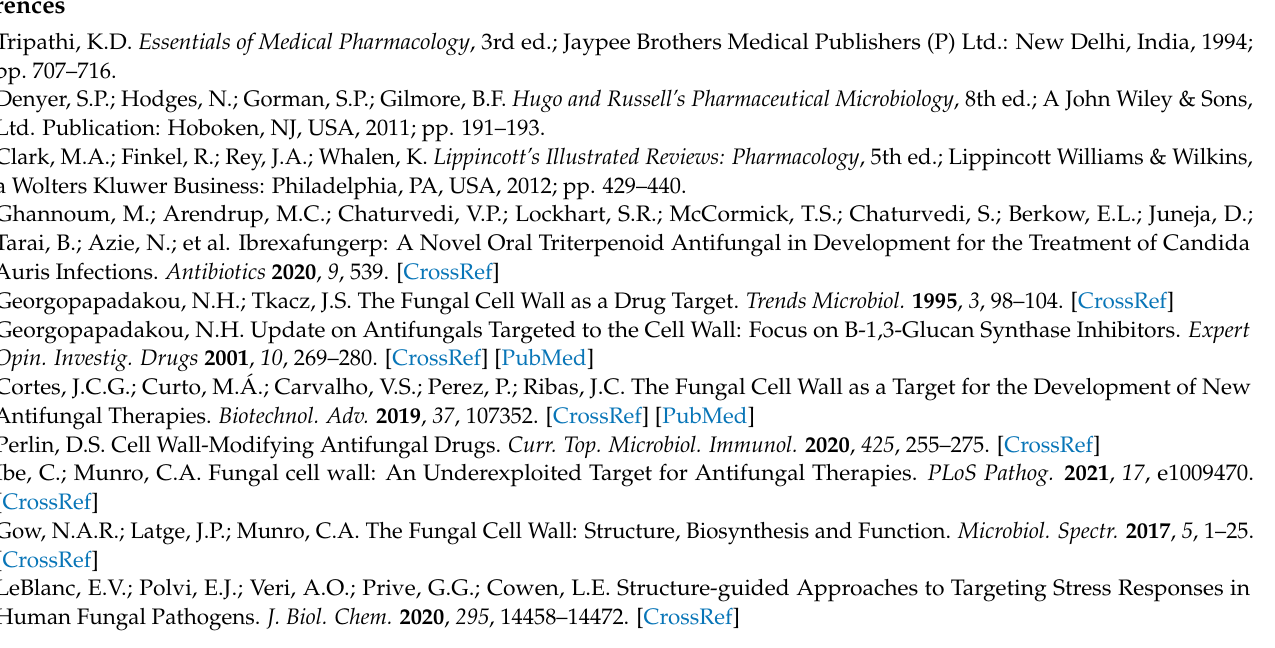
Figure S2: Fragments of 1 H NMR spectra of a solution of 7a in DMSO-d6, recorded at 25 ◦ C at 600 MHz at various time intervals after sample dissolution. Figure S3: Fragments of 1 H NMR spectra of a solution of 7a in CD 3 OH, recorded at 25 ◦ C at 600 MHz at various time intervals after sample dissolution. Figure S4: Hydrolysis of 6a and 7a to 1, 4a and benzoic acid in DMSO-d6 and CD 3